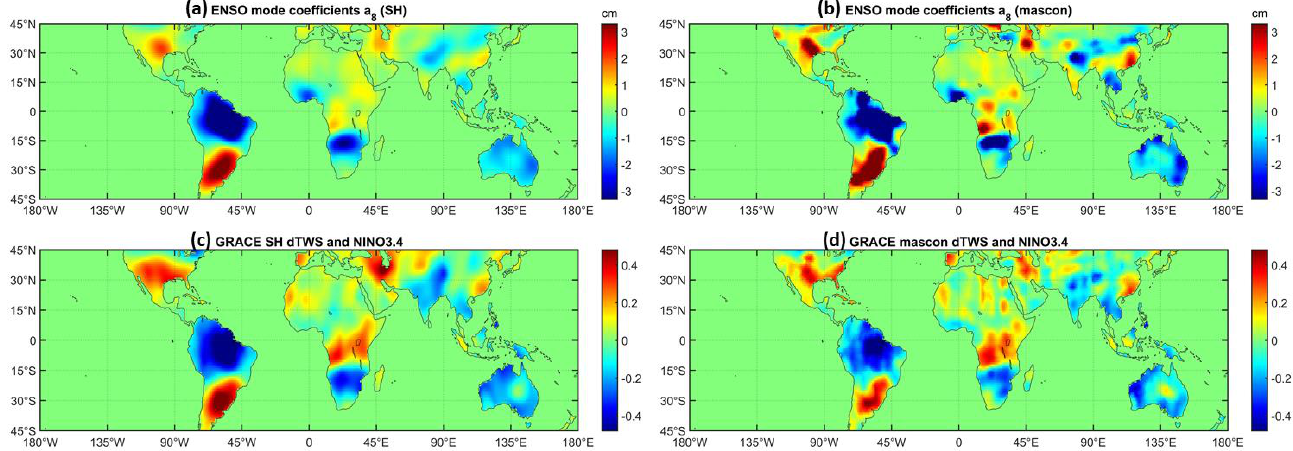
Figure 5. The same as Figure 4, but for ENSO coefficients, a 8 and cross correlation coefficients between interannual TWS flux and Niño 3.4 index. It should be noted that the TWS flux in this study means the quantitative difference of TWS changes between two adjacent months.